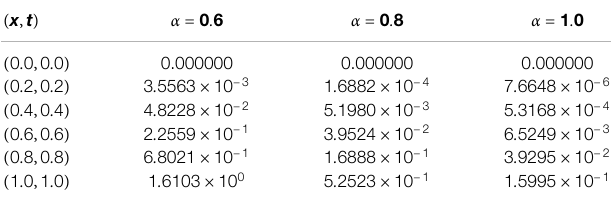
TABLE 2 | Values of RES